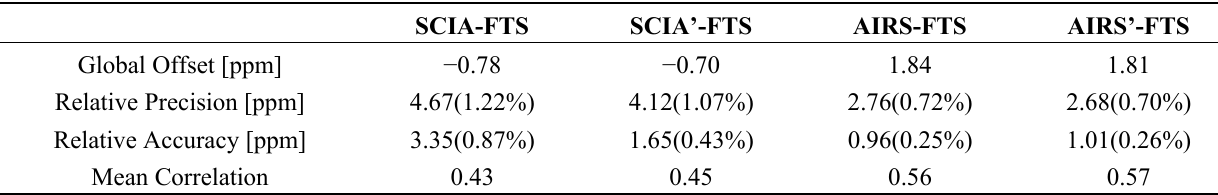
Table 8. Comparison of SCIAMACHY and AIRS data sets within ±2.5 degrees with the original data, where SCIA and AIRS are the original data; SCIA’ and AIRS’ are the sampled data within ±2.5